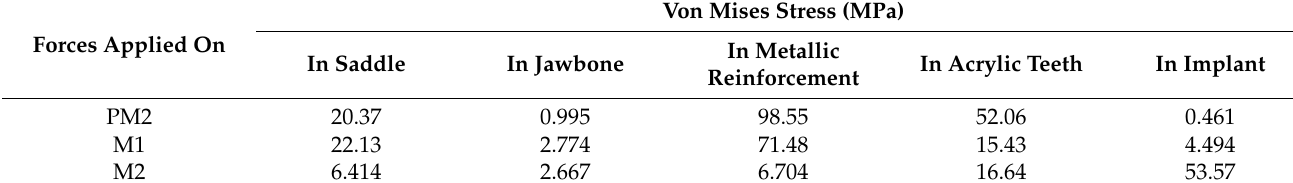
Table 4. The maximum von Mises stress (MPa) for the unilateral RPD with distal implant.